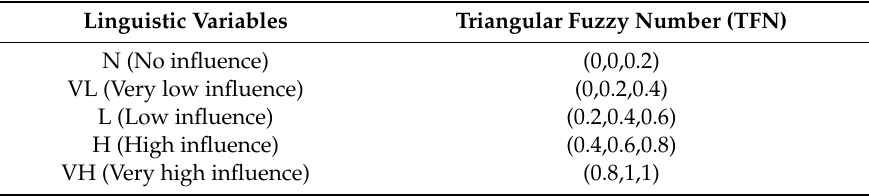
Table 3. Semantic transformation